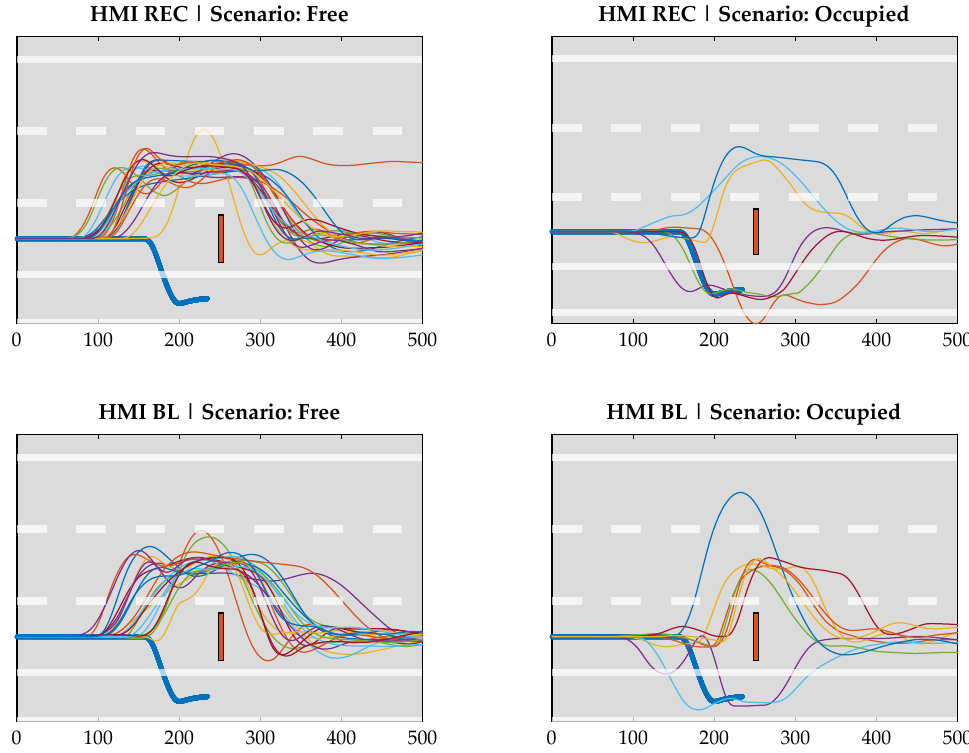
Figure 6. Trajectories of the center of gravity of the ego vehicle. The bue thick line shows the trajectory of the MRM and the transition phase starts at 0 m.